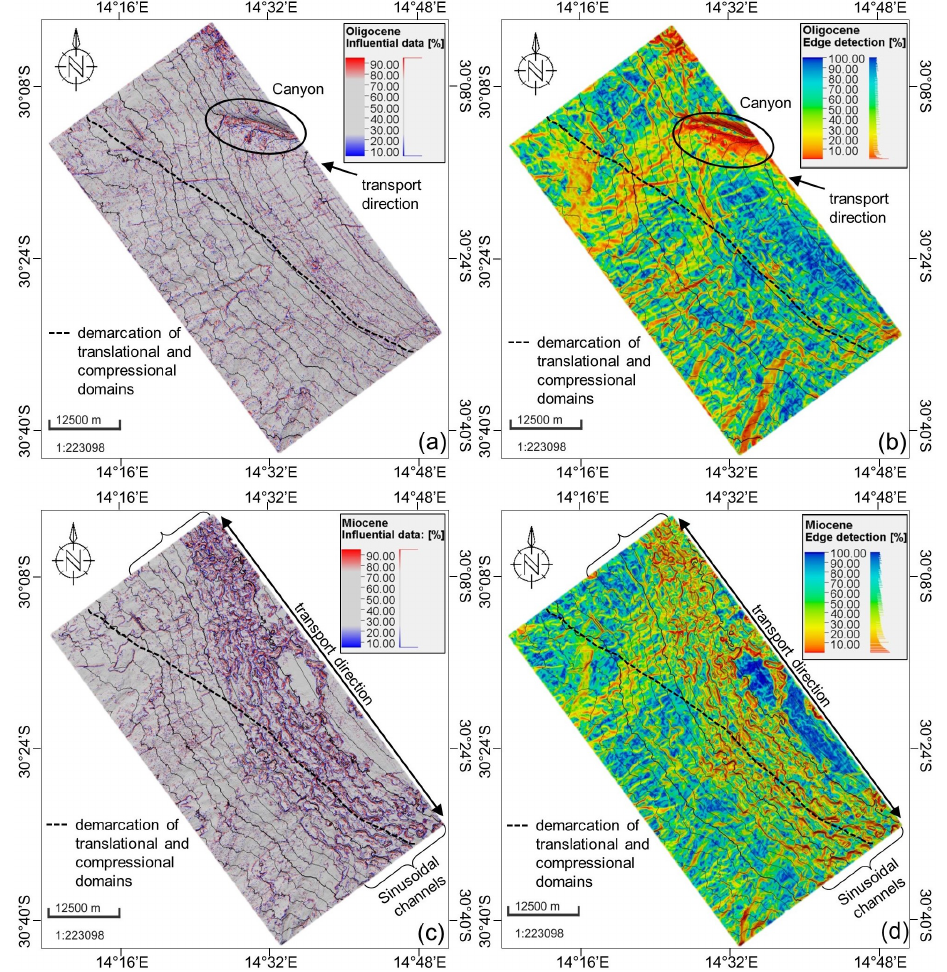
Figure 10. Cenozoic horizons showing the canyon-channel systems. Oligocene canyon formed by a downslope turbidity current viewed using the (a) influential data and (b) edge detection attributes. Miocene sinusoidal channels formed by an along-strike bottom current viewed using the (c) influential data and (d) edge detection attributes. Vertical exaggeration: